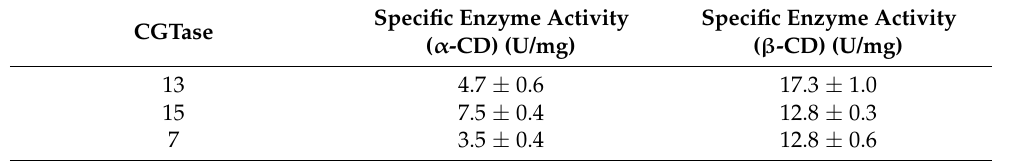
Table 7. Cyclization activity of